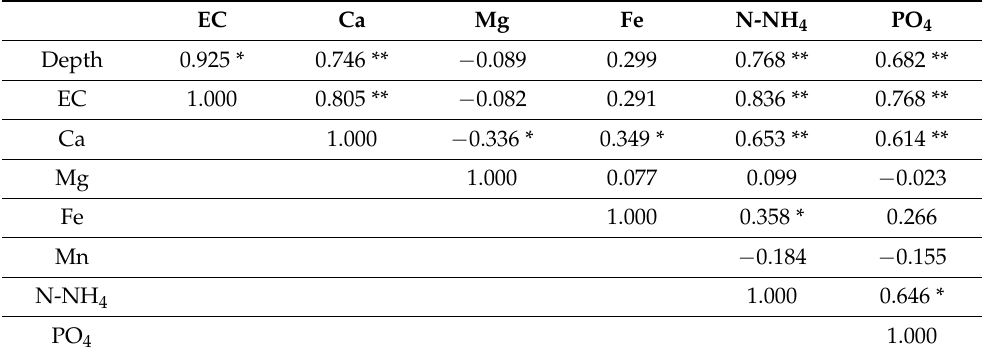
Table 4. Spearman’s rank correlation coefficients for selected chemical parameters of the moni-